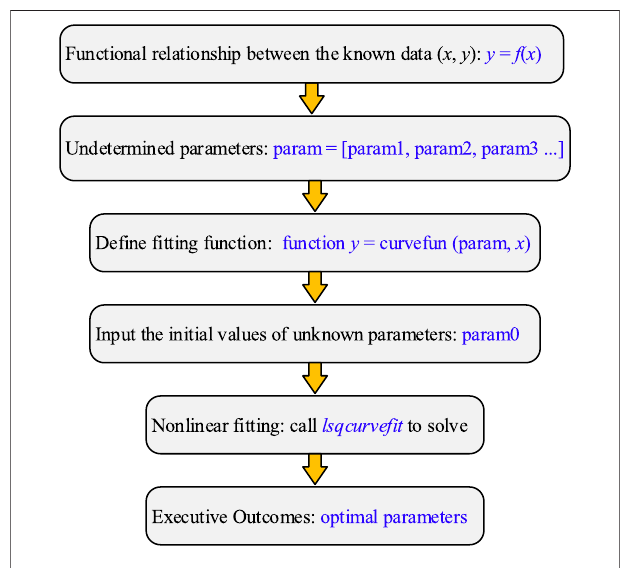
FIGURE 1 | Flowchart of the fi tting procedure.